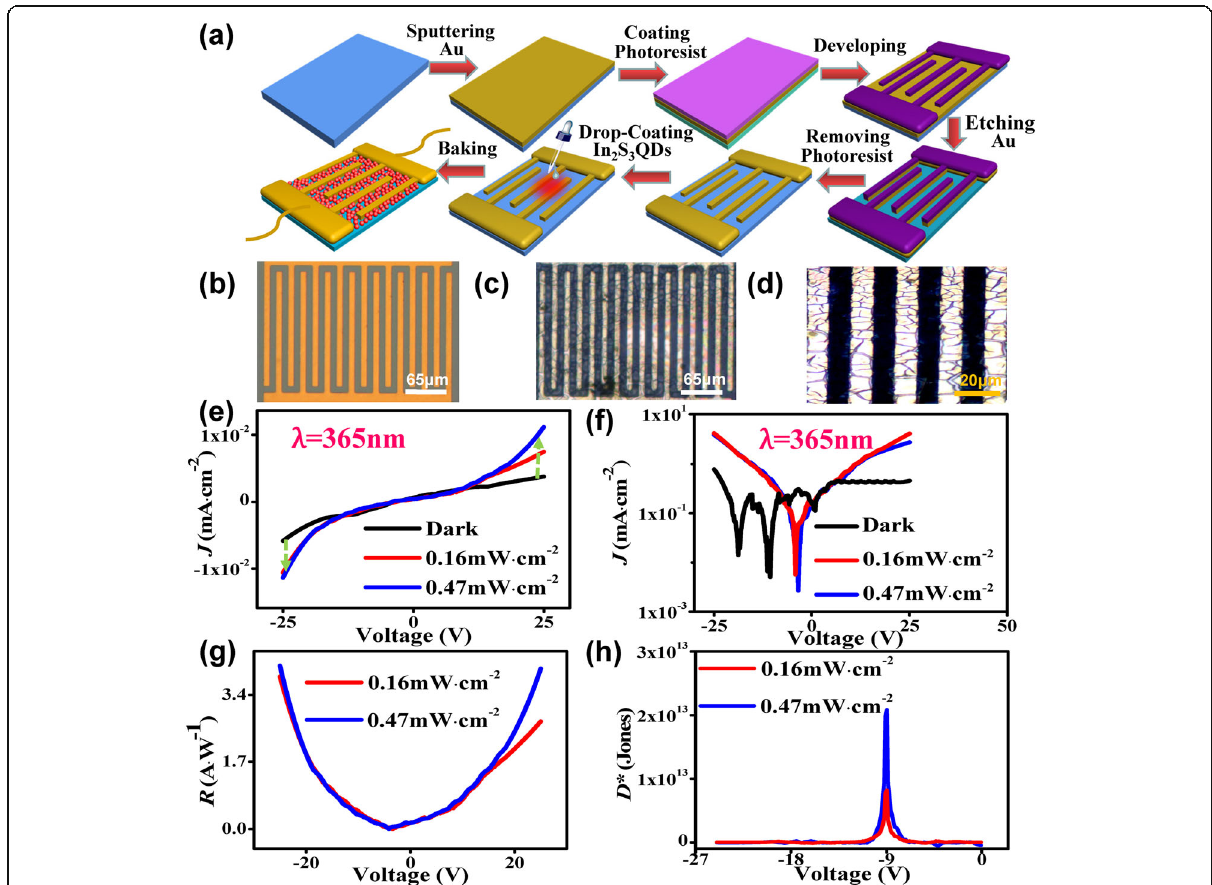
Fig. 3 a Schematic diagram illustrating the fabrication process of the In 2 S 3 QDs UV photovoltaic detector. b Electrode without QD. c – d Optical microscopic images of the In 2 S 3 QDs photodetector at different magnifications. e – h Performance of the In 2 S 3 QDs detector. e J-V curves. f Log (J)-V curves. g R (responsivity) -V curves. h